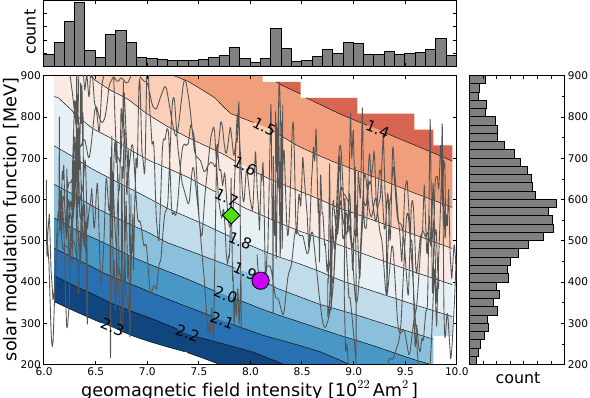
Fig. 13. The absolute radiocarbon production rate plotted as a func- tion of the solar modulation parameter 8 and VADM. Yearly values of the smoothed Q record are used (with a cutoff period of 20yr as in Fig. 10). The path taken by the model in this ( 8 , VADM)- space is indicated by the thin grey line. The circle shows the value of 8 for the normalisation period 1937–1950 as reported by Usoskin et al. (2011). The diamond shows the average production rate over the entire Holocene. On the sides of the figure, two histograms are displayed showing the relative occurrence of certain VADM (top panel) and 8 (right panel) values, ∼ 565MeV being the median modulation potential during the